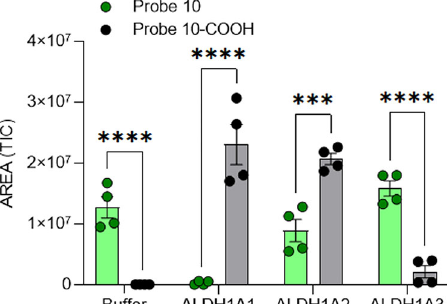
Fig. 4 LC-HRMS analysis for the determination of interaction of Probe 10 with the different isoenzymes of ALDH1A. LC-HRMS results after 1 h of incubation of single isoenzyme with Probe 10 in presence of ALDH1A1, ALDH1A2 and ALDH1A3. It is possible to appreciate the formation of the corresponding acid (Probe 10-COOH ) for 1A1 and 1A2 but not for ALDH1A3. (TIC total ion